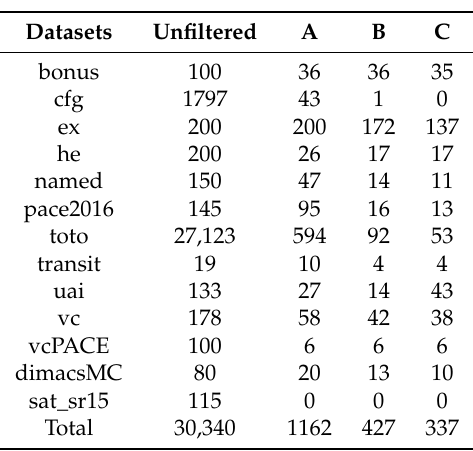
Table 1. The total number of graphs per source dataset and the number of those graphs in filtered datasets A, B and C (see Sections 4.1 and 4.2 for clarification).